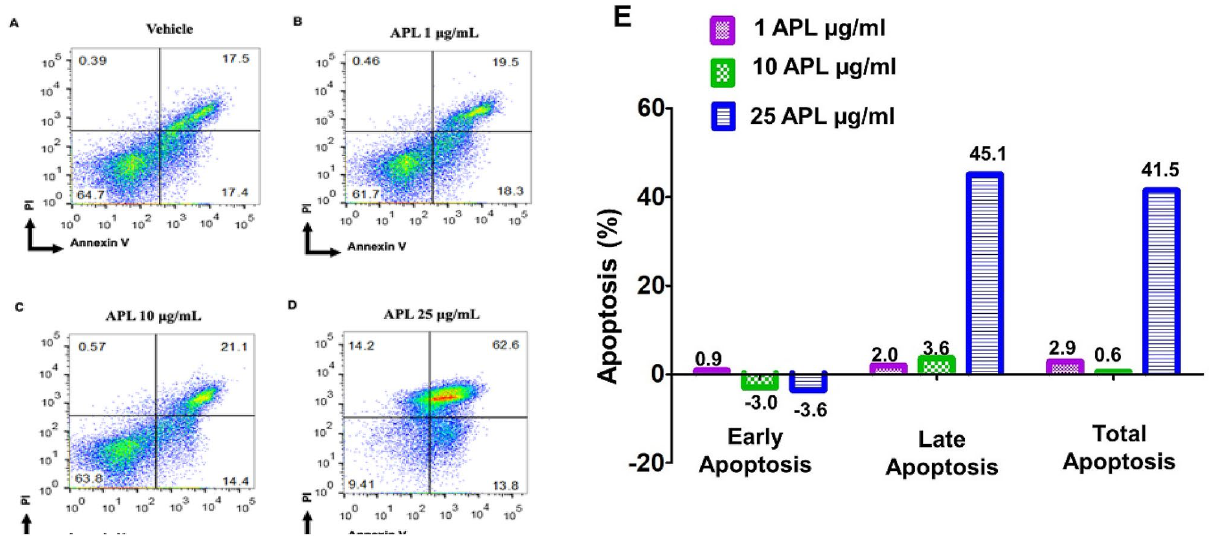
Figure 4. Apoptosis in EL4 cells by APL: This was determined by Annexin V-PI staining after 24 h treatment with vehicle ( A ) or APL ( Psiadia lithospermifolia ) at different concentrations such as 1 µg/ml ( B ), 10 µg/ml ( C ), 25 µg/ml ( D ). The data presented are representative of three independent experiments. Bar chart ( E ) shows quantitative data of average of three independent flow cytometry experiments with apoptosis in APL groups relative to vehicle controls.